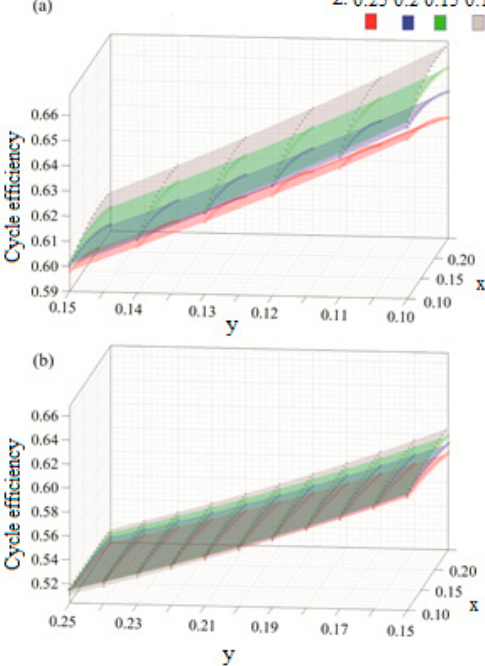
Figure 8. Efficiency results with respect to variable molar fractions of x: argon, y: H 2 O and z: CO 2 , for ( a ) y = [0.1–0.15] and ( b ) y = [0.15–25].